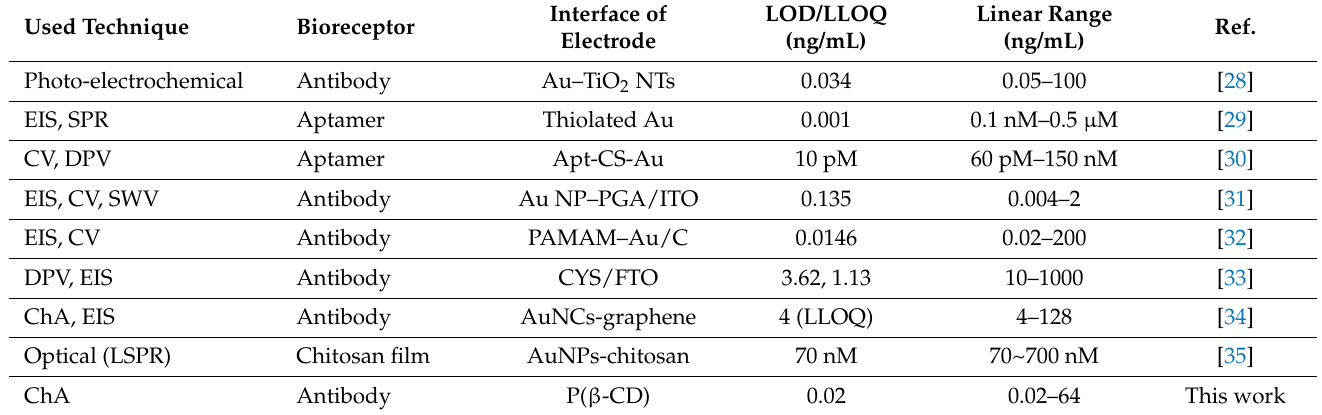
Table 2. Comparing our proposed α -syn immunosensor with other α -syn